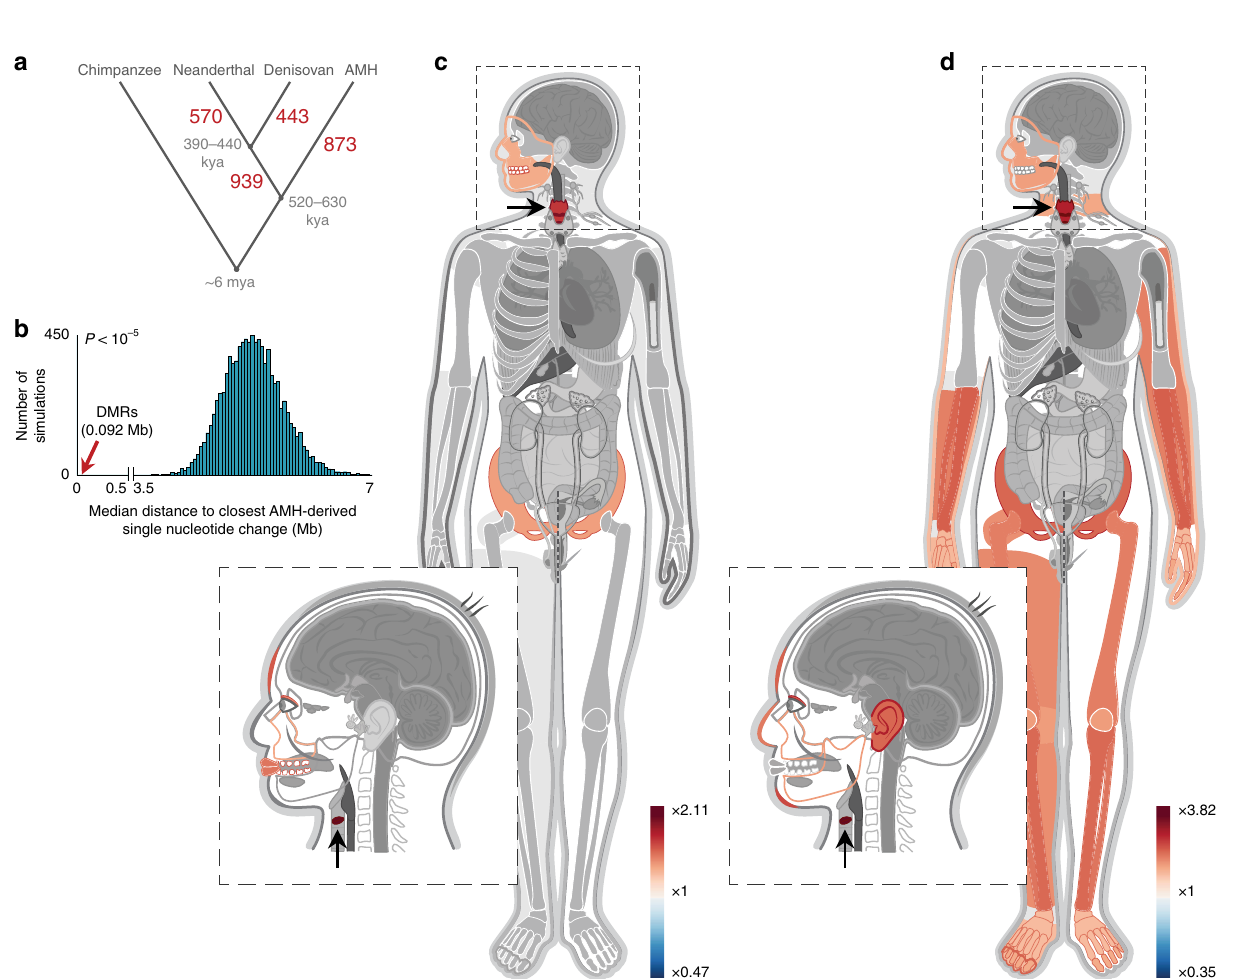
Fig. 2 Genes affecting voice and face are the most over-represented within AMH-derived DMRs. a The number of DMRs that emerged along each of the human branches. Divergence times are in thousands of years ago (kya). b Distribution of median distances (turquoise) of DMRs to randomized single nucleotide changes that separate AMHs from archaic humans and chimpanzees. Genomic positions of single nucleotide changes were allocated at random. This was repeated 10,000 times. Red arrow marks the observed distance of DMRs, showing that they tend to be signi fi cantly closer to AMH-derived single nucleotide changes than expected by chance. This suggests that some of these sequence changes might be associated with the changes in methylation. c A heat map representing the level of enrichment of each anatomical part within the AMH-derived DMRs. Only body parts that are signi fi cantly enriched (FDR < 0.05) are colored. Three skeletal parts are signi fi cantly over-represented: the face, pelvis, and larynx (voice box, marked with arrows). d Enrichment levels of anatomical parts within the most signi fi cant (top quartile, Q statistic) AMH-derived DMRs, showing a more pronounced enrichment of genes affecting vocal and facial skeleton (e.g., endochondral bone morphogenesis, trabecula morphogenesis, and palate development). Also notable are terms associated with the muscular, cardiovascular, and nervous sys- tems (Supplementary Data 3).